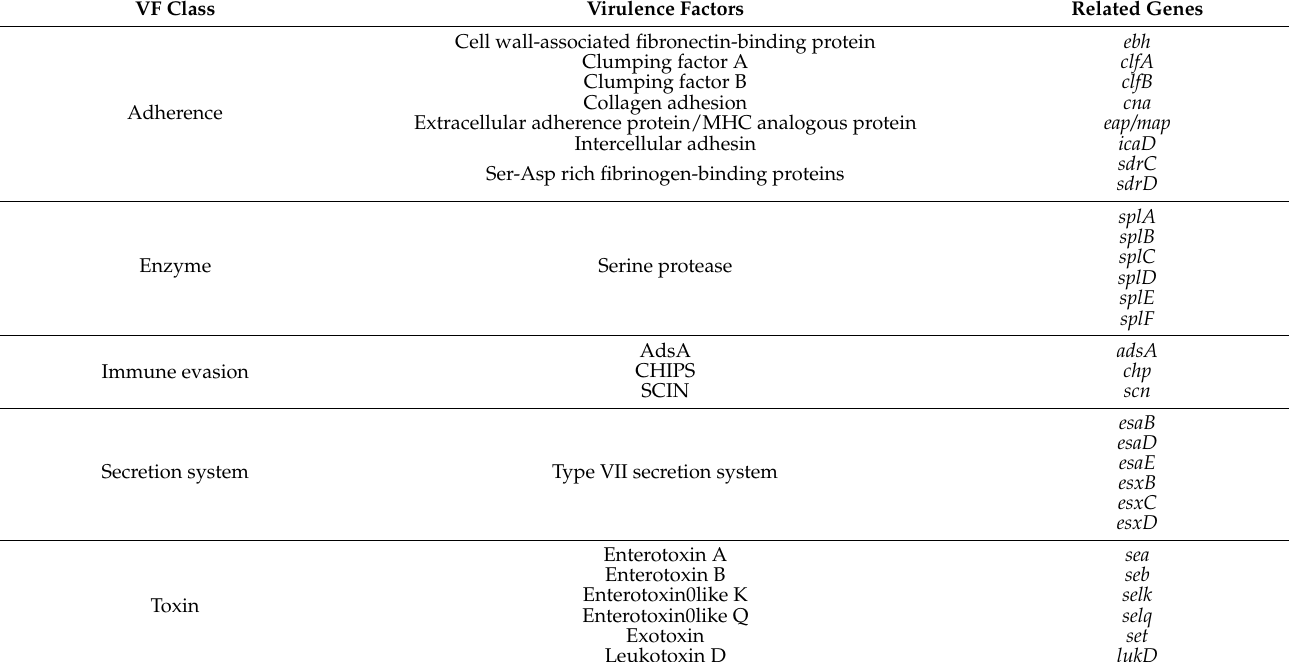
Figure 2. Differential distribution heat map of the drug resistance and virulence factors of 14 strains. ( a ) Differential distribution heat map of the drug resistance of 14 strains. ( b ) Differential distribution heat map of the virulence factors of 14 strains. Table 1. Functional classification of 14 strains of virulence factors predicted by